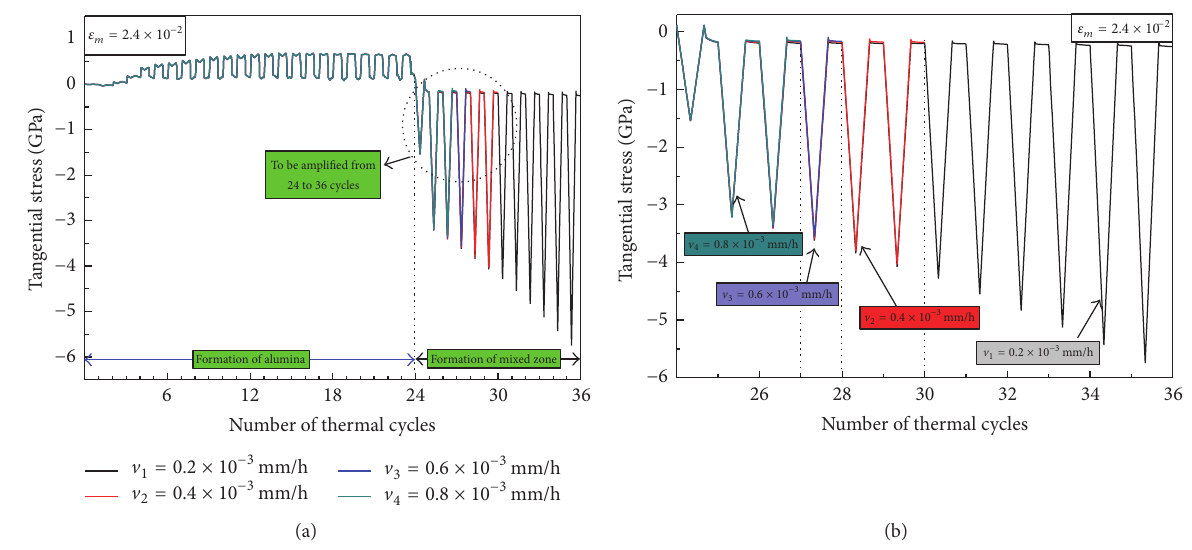
Figure 6: (a) The variation of the tangential stress at element number 20857 at the base of the surface groove against the number of thermal cycles when 𝜀 𝑚 = 2.4 × 10 −2 . (b) The details for the variation of tangential stress during the formation of MZ.